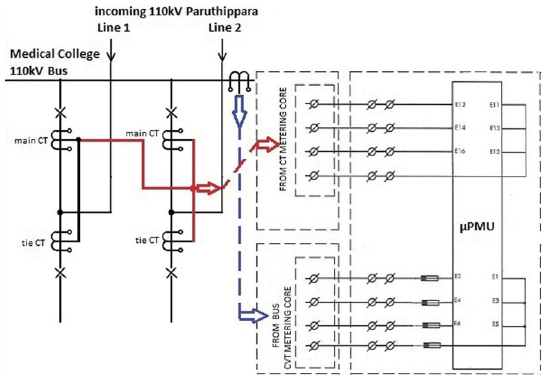
Fig. 9 Single Line Diagram of PMU deployment